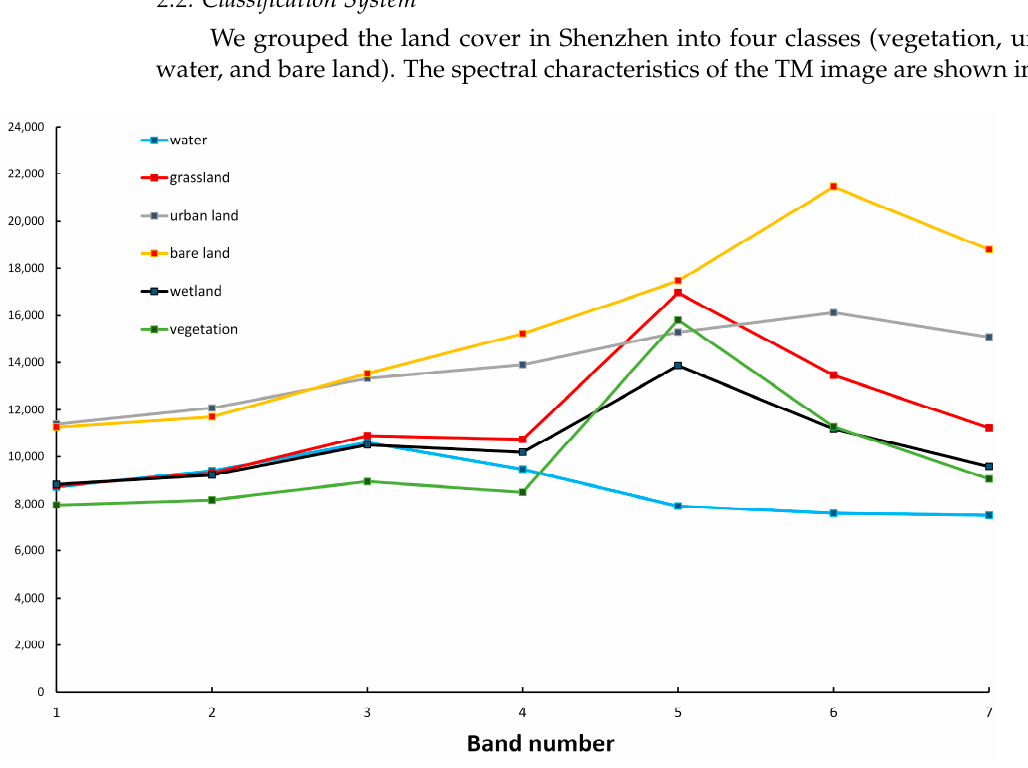
Table 1. Parameters of the used Landsat images.